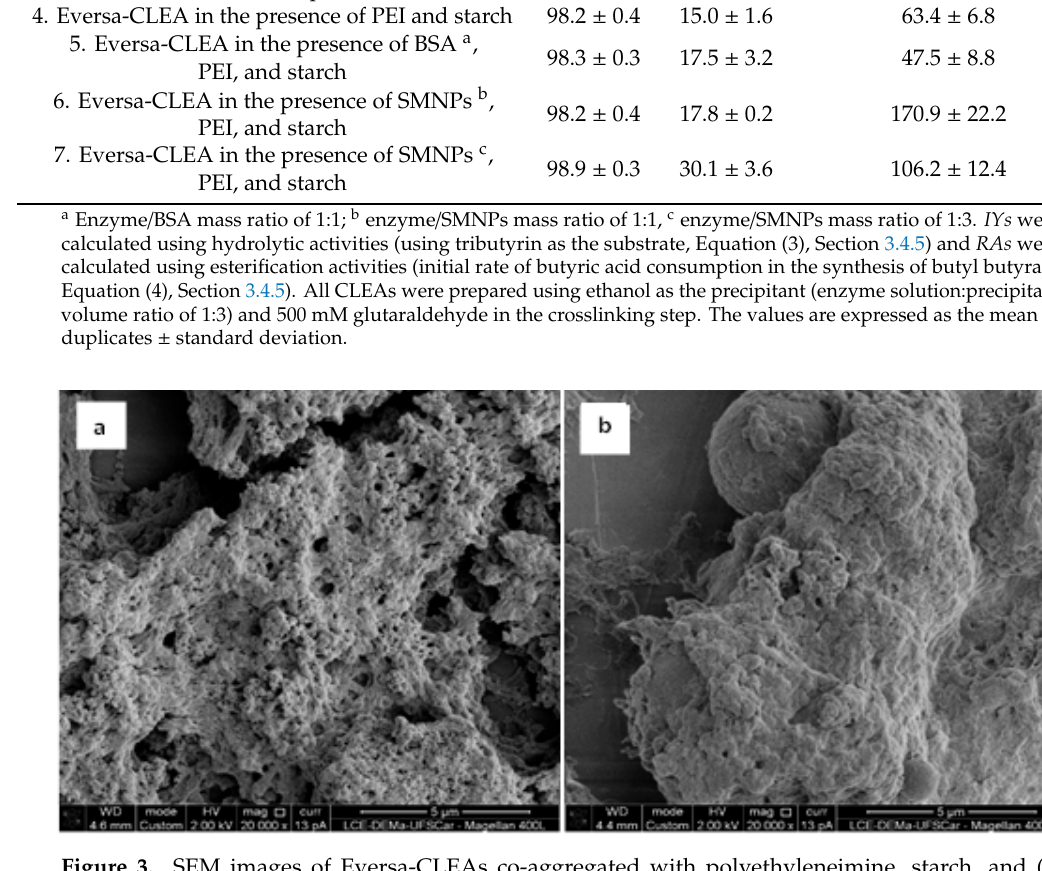
Figure 3. SEM images of Eversa-CLEAs co-aggregated with polyethyleneimine, starch, and ( a ) silica magnetic nanoparticles (nanoparticles / enzyme mass ratio of 1:1) or ( b ) bovine serum albumin. The CLEAs were prepared under the same conditions.